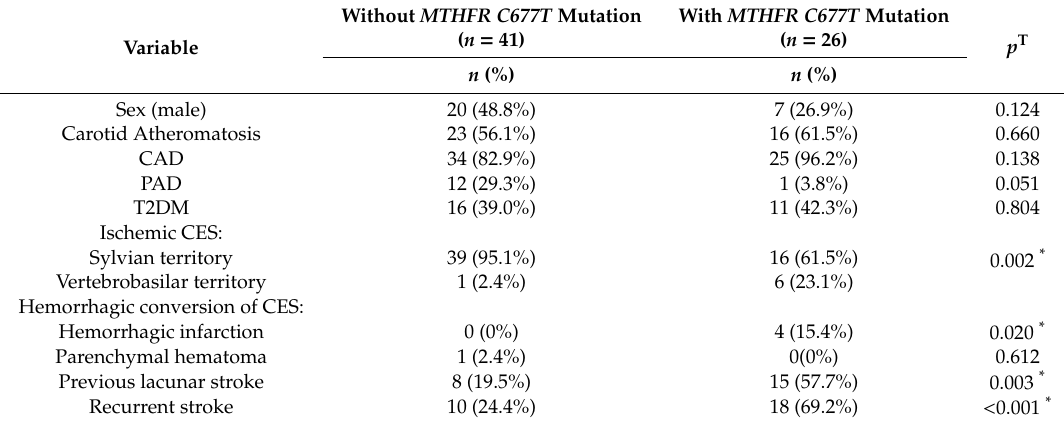
Table 2. Variable comparisons regarding of cardiovascular comorbidities and stroke localization. for MTHFR C677T mutation ( n = 67) using the Chi 2